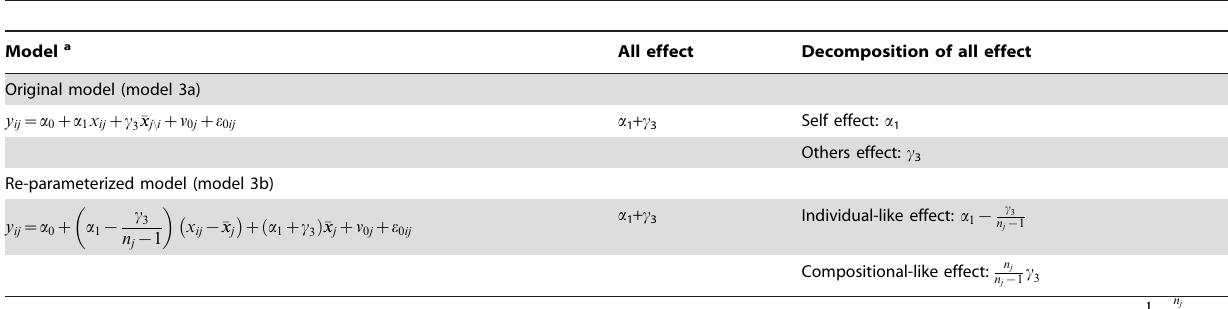
Table 4. Decomposition of effect of self-excluded model (3a) and its re-parameterized form (3b).